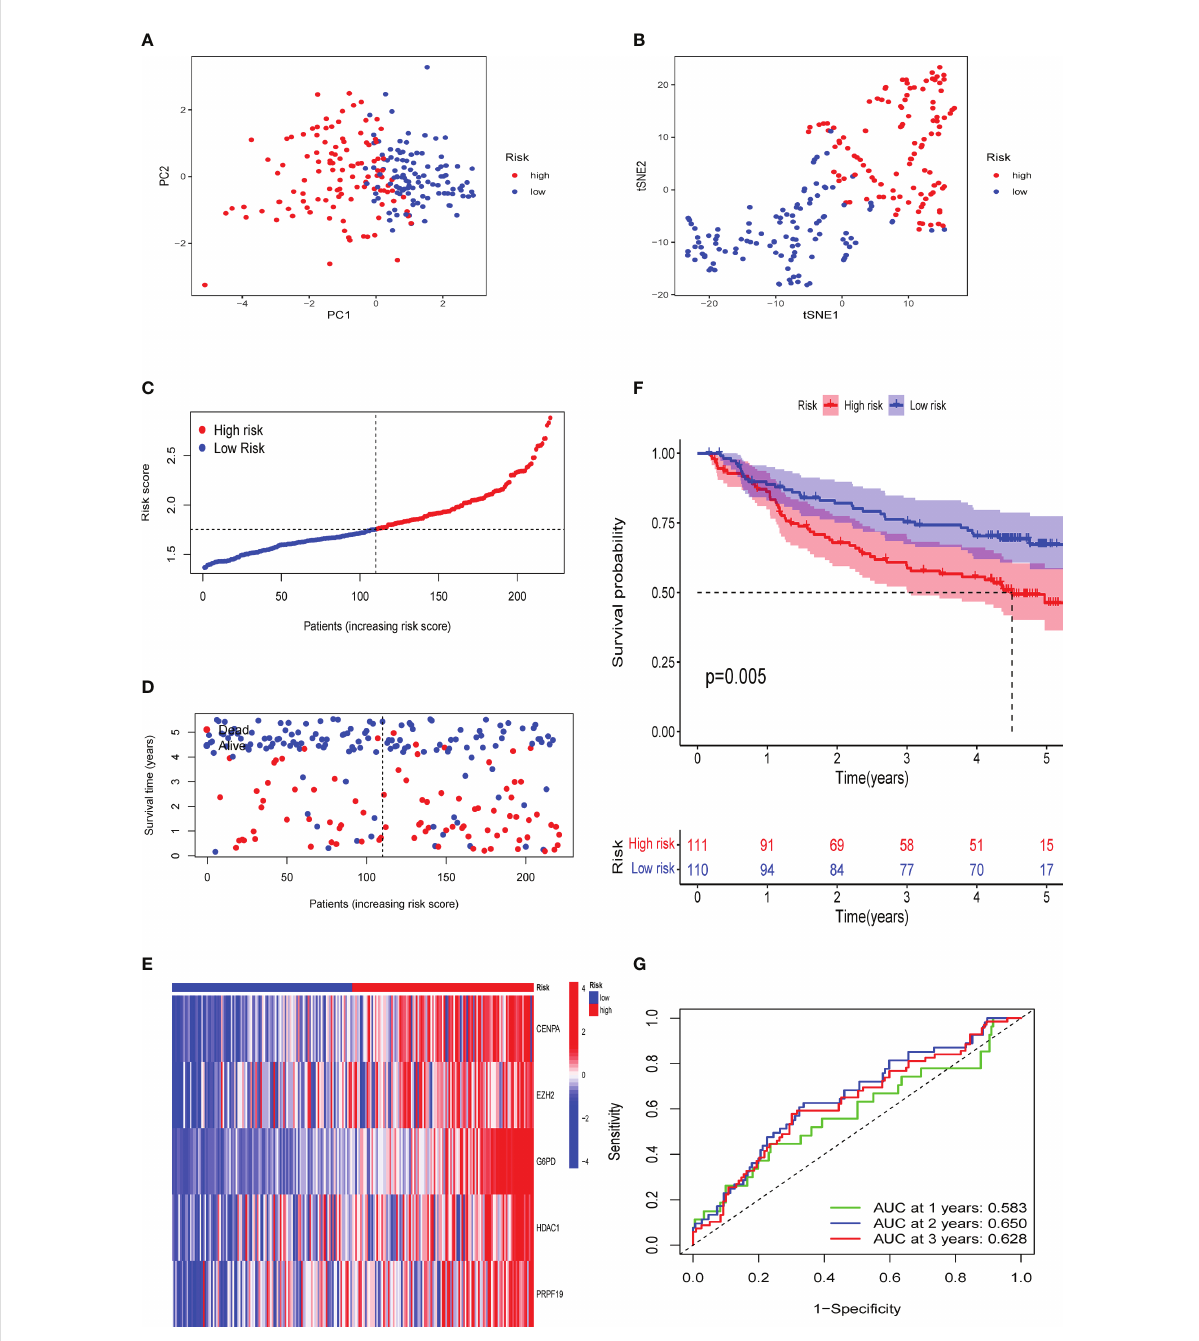
FIGURE 6 Validation of the CS signature in the veri fi cation cohort ICGC-LIRI. (A) PCA and (B) t-SNE analysis of the ICGC-LIRI cohort. (C, D) Patterns of alteration in patient survival status and survival time between the high- and low-risk groups based on the accumulation in CS scores. (E) Heat map visualization of the expression trend of 5 CS genes with increasing CS score in the ICGC-LIRI cohort. (F) Survival analysis of patients in the high-risk and low-risk groups in the validation cohort ICGC-LIRI. (G) Validation of time-dependent ROC curve results for the risk model in the